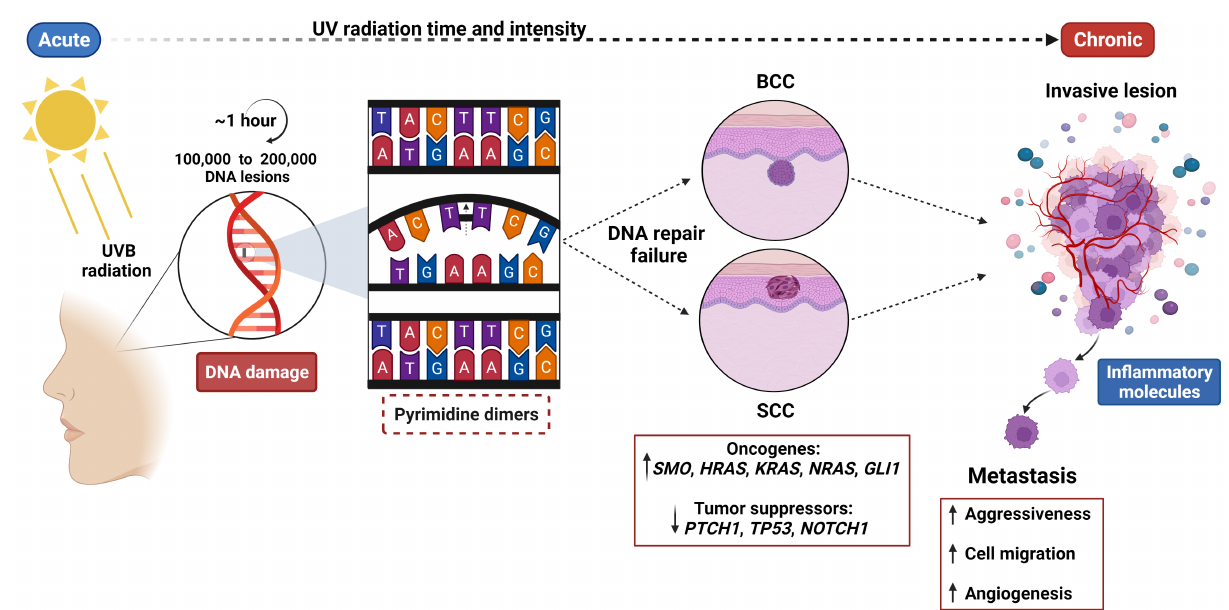
Figure 1. Environmental and genetic risk factors for non-melanoma skin cancer (NMSC). Environ- mental risk factors implicated in NMSC development are based on the intensity and time of UVB radiation upon exposed skin areas, and more importantly in the DNA of epidermal cells such as keratinocytes. These DNA lesions accumulate during UVB radiation exposure, which can be absorbed and generate DNA structural alterations such as cyclobutane pyrimidine dimers, causing the repair mechanisms to fail at some point and affecting replication and transcription cell processes. As a consequence, this interrupted gene function—especially with genes implicated in the regulation of cell proliferation, differentiation, and DNA repair—leads to skin cancer establishment, which will present higher rates of aggressiveness due to a progressive increase in inflammatory molecule activation, cell migration and angiogenesis. The present figure was created with BioRender.com, accessed on 4 May 2022. All icons, templates, and other original artwork appearing in the attached completed graphic are pursuant to BioRender’s Academic License